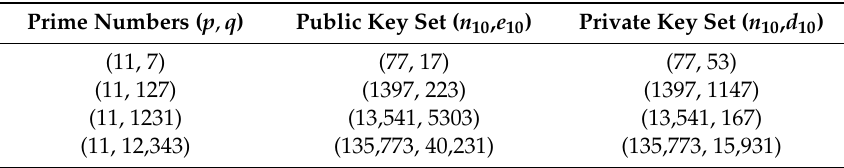
Table 1. Example of various asymmetric RSA encryption